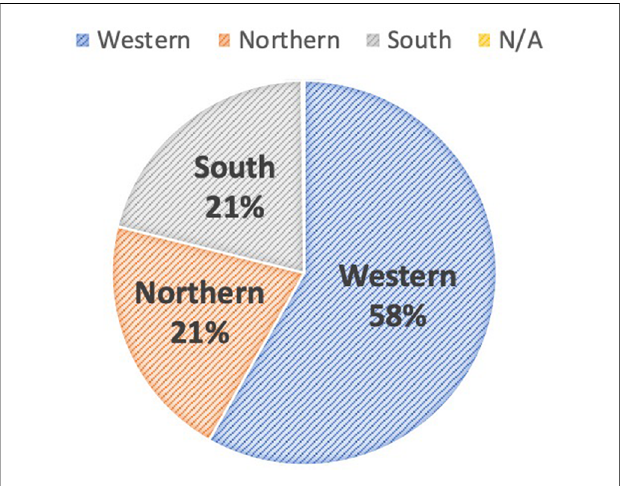
FIGURE 6 Regional distribution of subscribers who are aged 18 – 24 years ( n=2.03 million